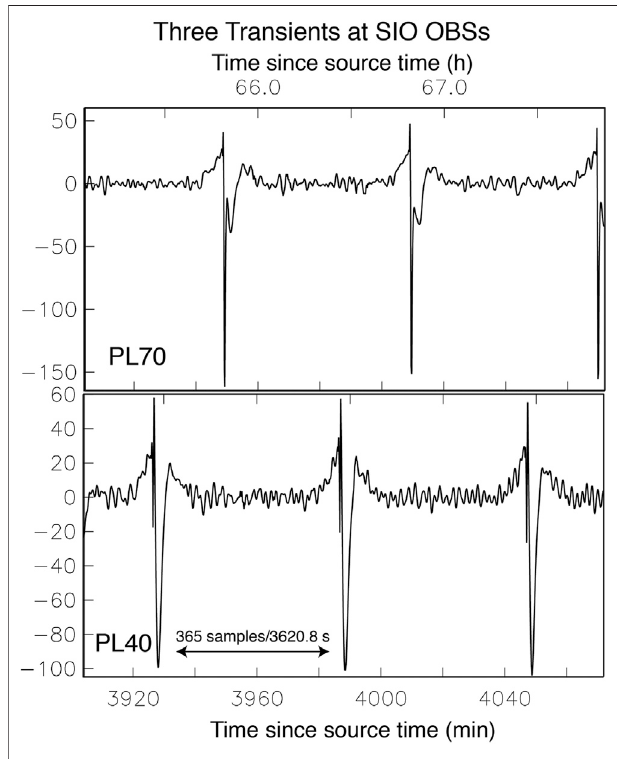
FIGURE 9 | A sequence of three low-frequency transients in the bandpass fi lteredtimeseriesoftheverticalcomponentofSIOOBSsPL40and PL70 many hours after the November 15, 2006 Kuril Islands earthquake. Spectral analysis indicates that the distance between pulses is 3,620.56 s, which is about 365 samples (a sample is 9.92 s, so 365 samples would be 3,620.8 s; see text for